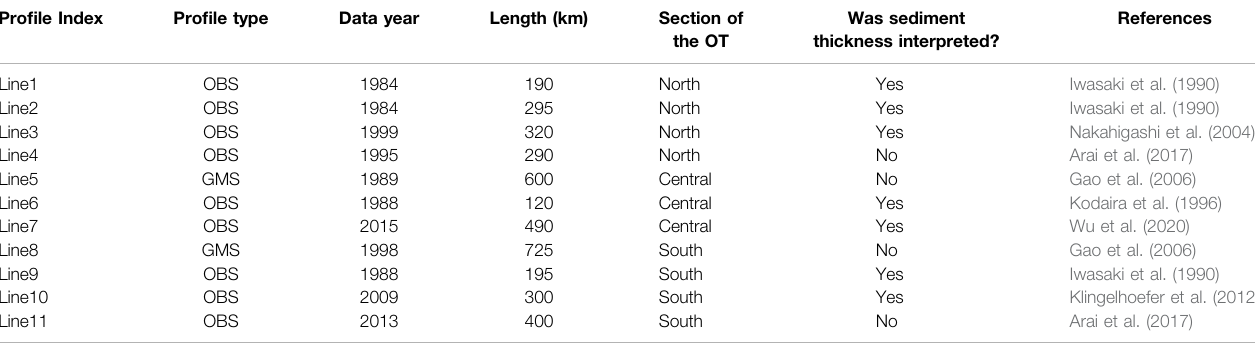
TABLE 1 | Information on the geophysical pro fi les used in this